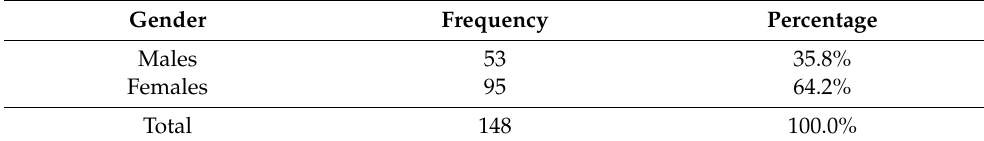
Table 1. Gender distribution of the affected patients.